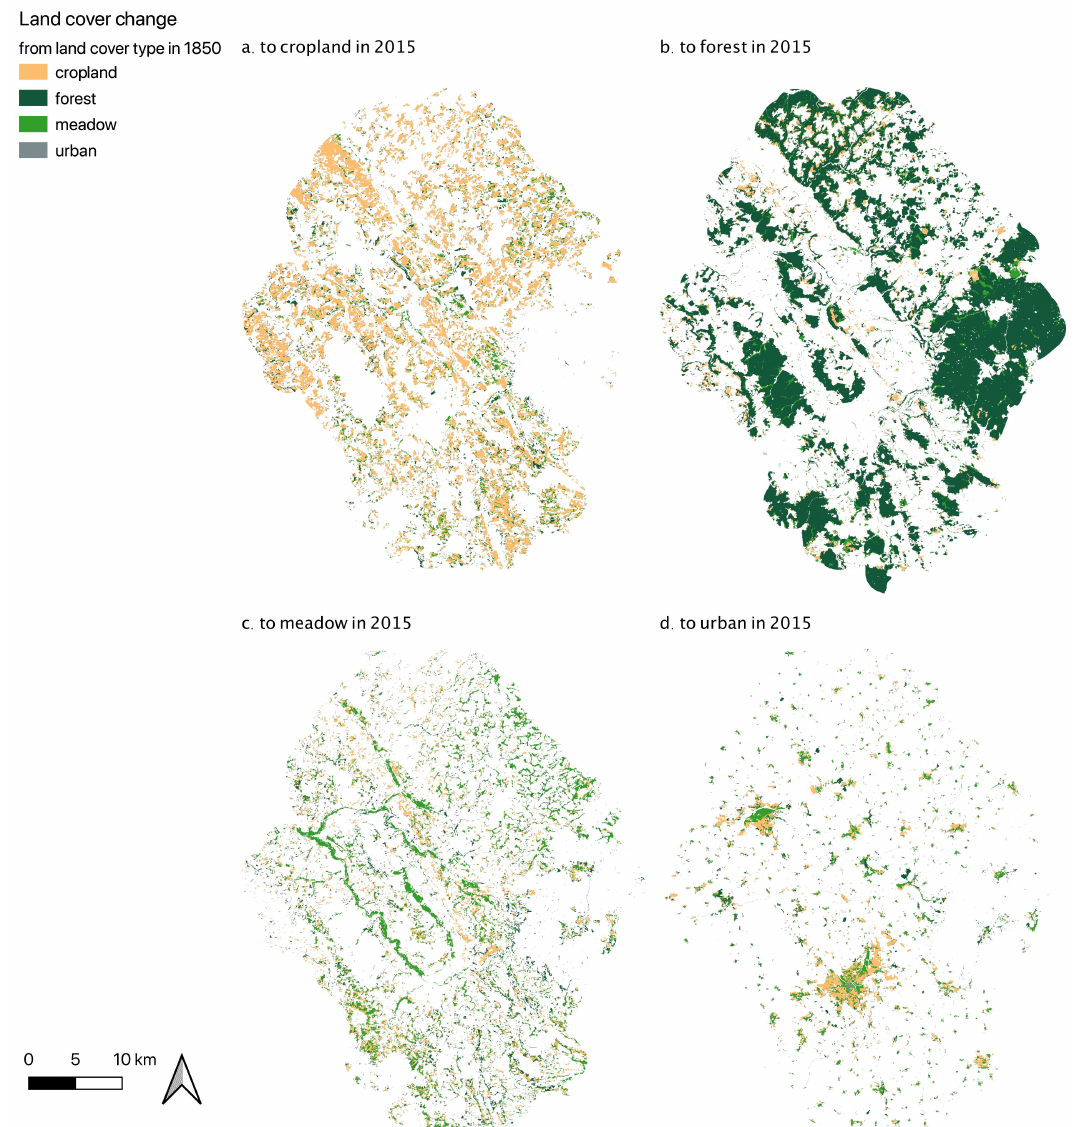
Figure 4. ( a – d ) Land cover change in the catchment of the Red and White